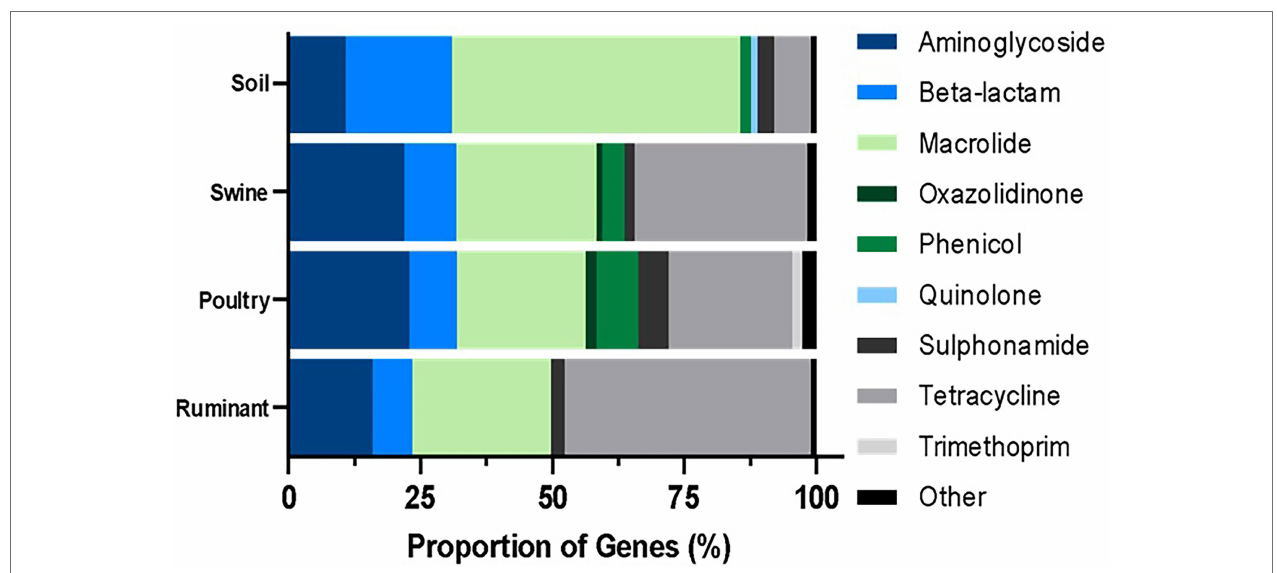
FIGURE 3 | Percentage resistance genes grouped by antibiotic class per microbiome type. The ARG were identified by BLASTn and the proportion was estimated by the dividing the number of distinct resistance genes per antibiotic class by the total number of resistance genes for all